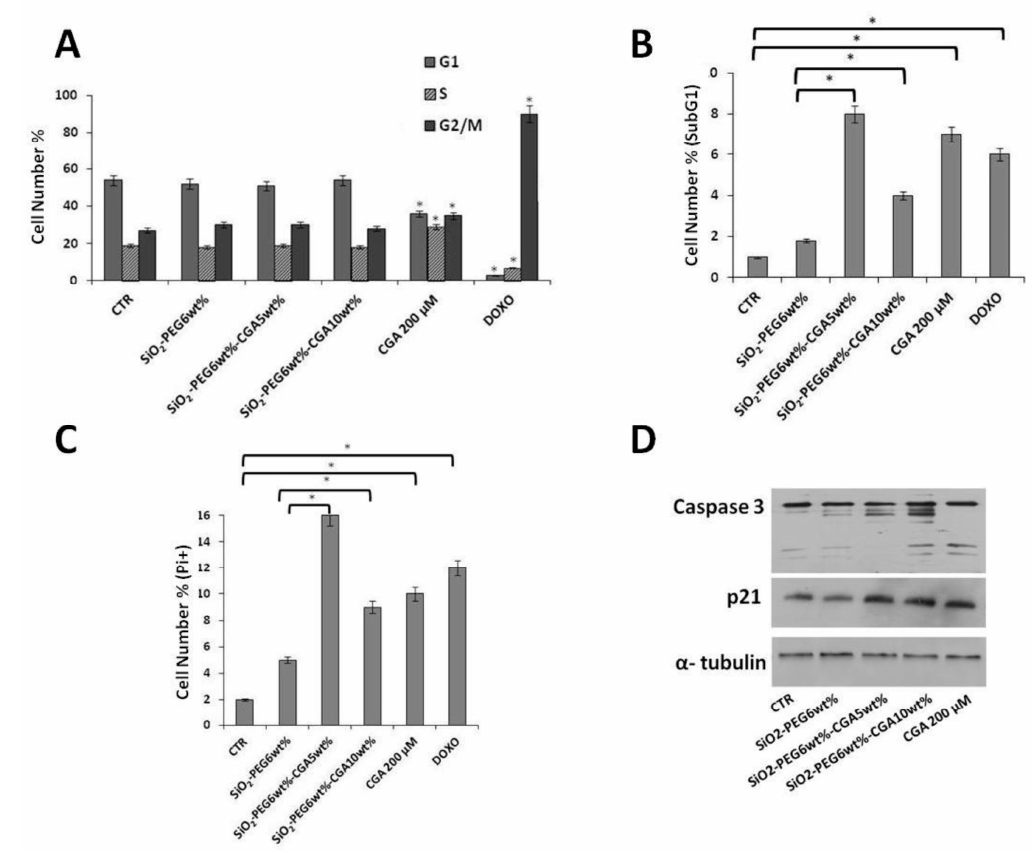
Figure 8. Effects of CGA-free SiO 2 /PEG hybrid 0.5 mg/mL, 5%CGA-containing SiO 2 /PEG hybrid 0.5 mg/mL, 10%CGA-containing SiO 2 /PEG hybrid 0.5 mg/mL, pure CGA 200 µ M, and doxorubicin 0.1 µ M on the distribution of U2OS cells in cell cycle phases and on cell death. U2OS cells were cultured in presence or not of doxorubicin for 24 h and of all the other indicated compounds for 48 h. Subsequently, cell cycle phases (Panel A ), sub-G1 (Panel B ) or uptaking PI+ dead cells (Panel C ) were evaluated by Flow Cytometry. Quantitative data from three independent experiments indicating the percentage of sub-G1, G1, S, and G2/M cells or the percentage of dead cells are reported. The means and S.D. are shown. * p < 0.05 vs. the control untreated cells (Panel A ) or vs. the indicated samples (Panels B and C ). In (Panel D ), 30 µ g of cell extracts were subjected to SDS-PAGE and blotted with antibodies against the indicated proteins. The image is representative of immunoblotting analysis from two different cellular preparations with similar results.